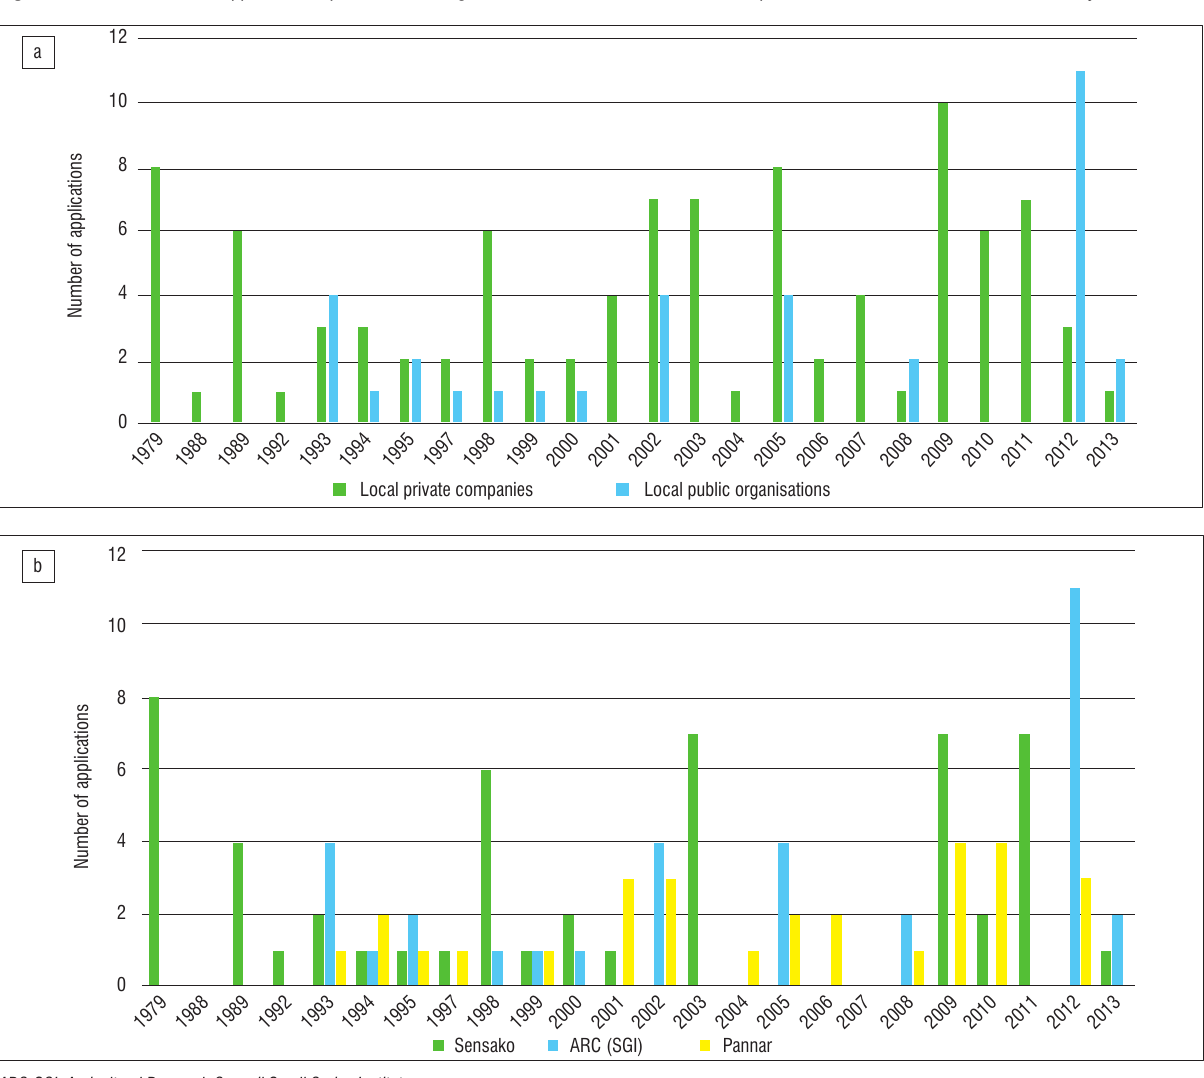
Figure 3: The structure of applicants for plant breeders’ rights for wheat from 1979 to 2013, compiled from data in South African Plant Variety Journals.